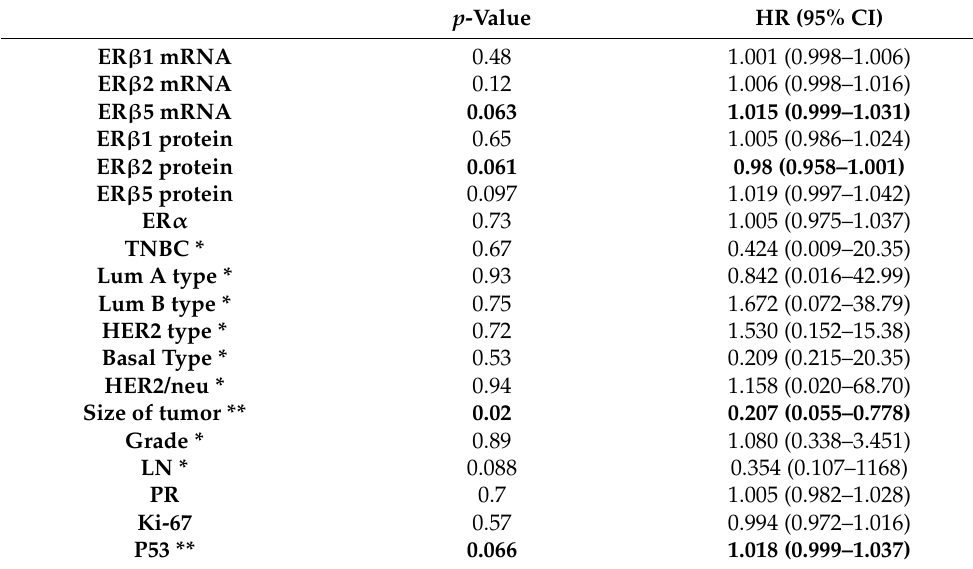
Table 6. Multivariate cox PH analysis of ER β expression and clinical characteristics for overall